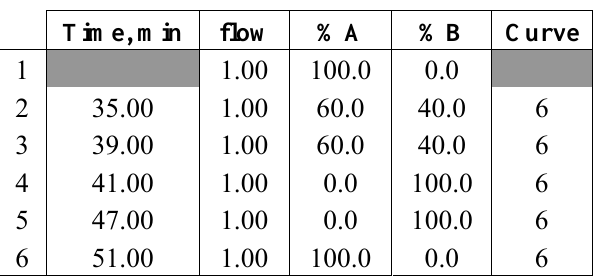
Table 5. HPLC gradient